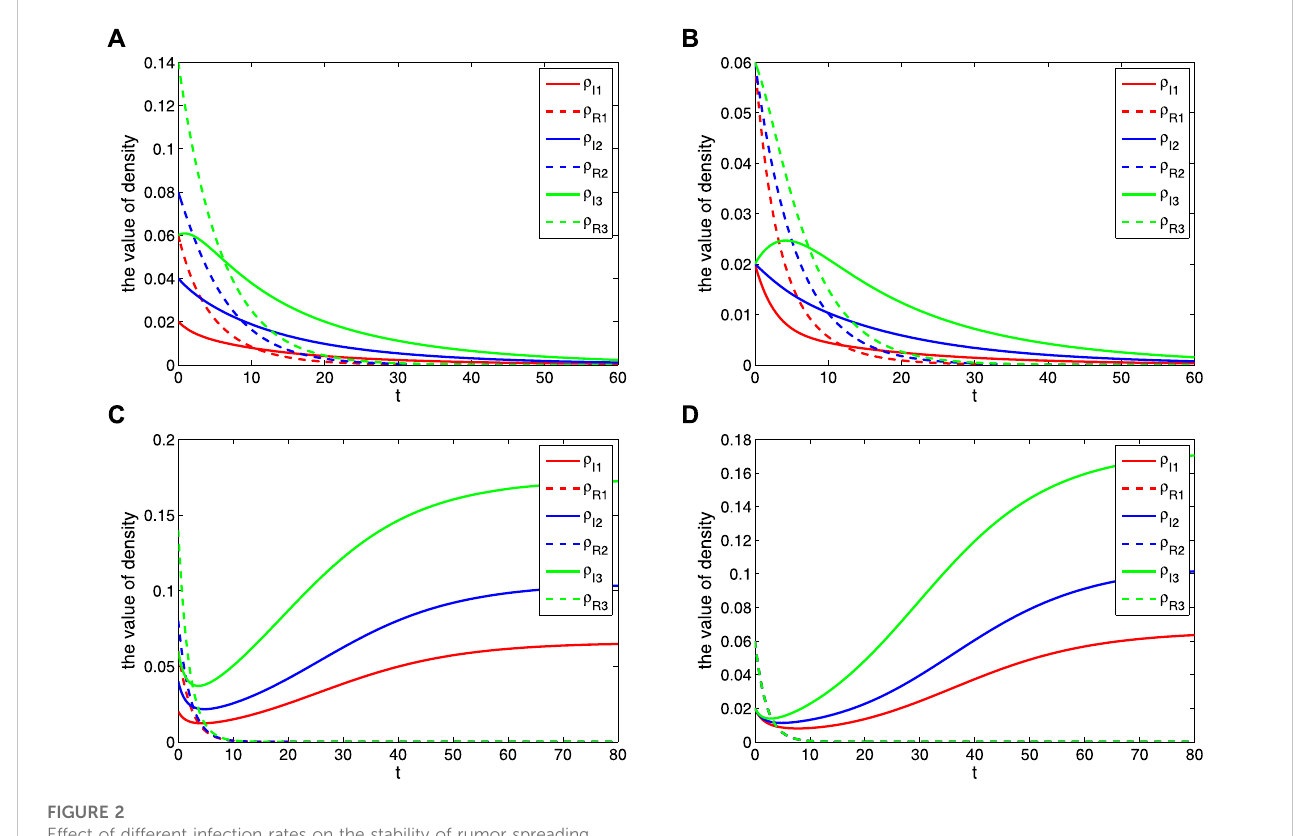
FIGURE 2 Effect of different infection rates on the stability of rumor